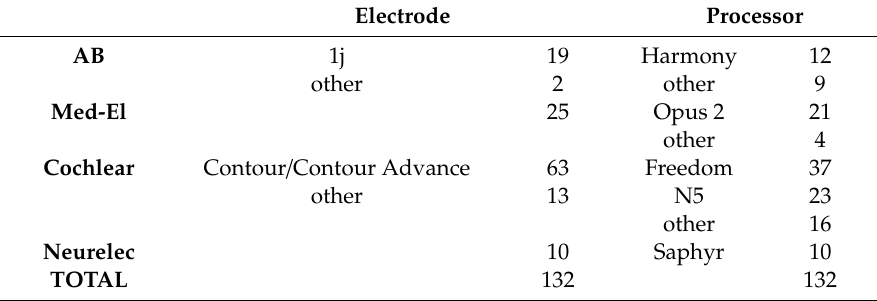
Table 2. Cochlear implant brand, electrode, and speech